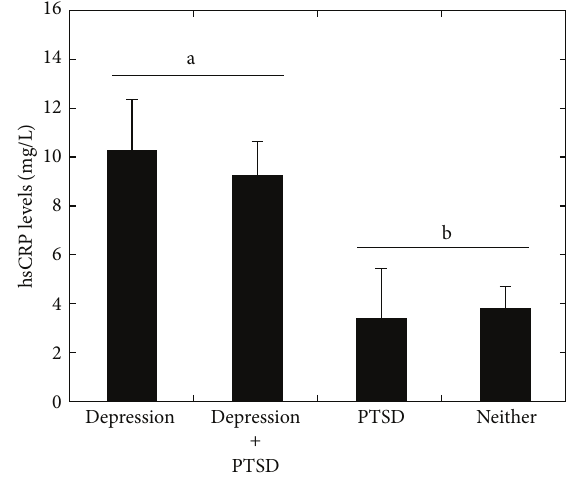
Figure 1: Univariate analysis of variance results predicting mean hsCRP levels by current depression and PTSD diagnoses. Significant main effect of depression denoted by letters ( 𝑝 < 0.001